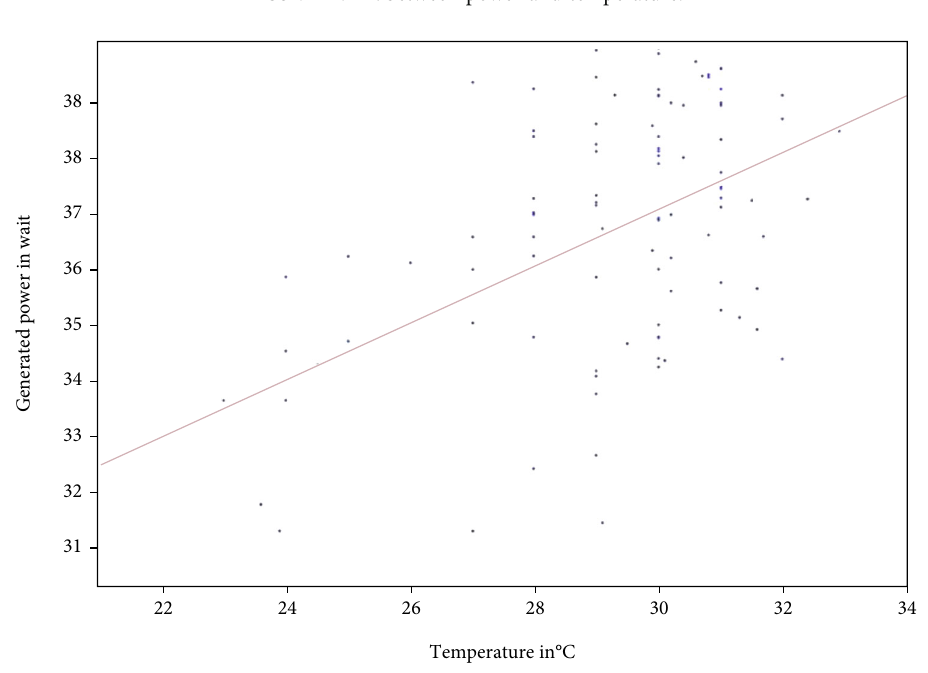
Figure 12: PR between power and temperature.